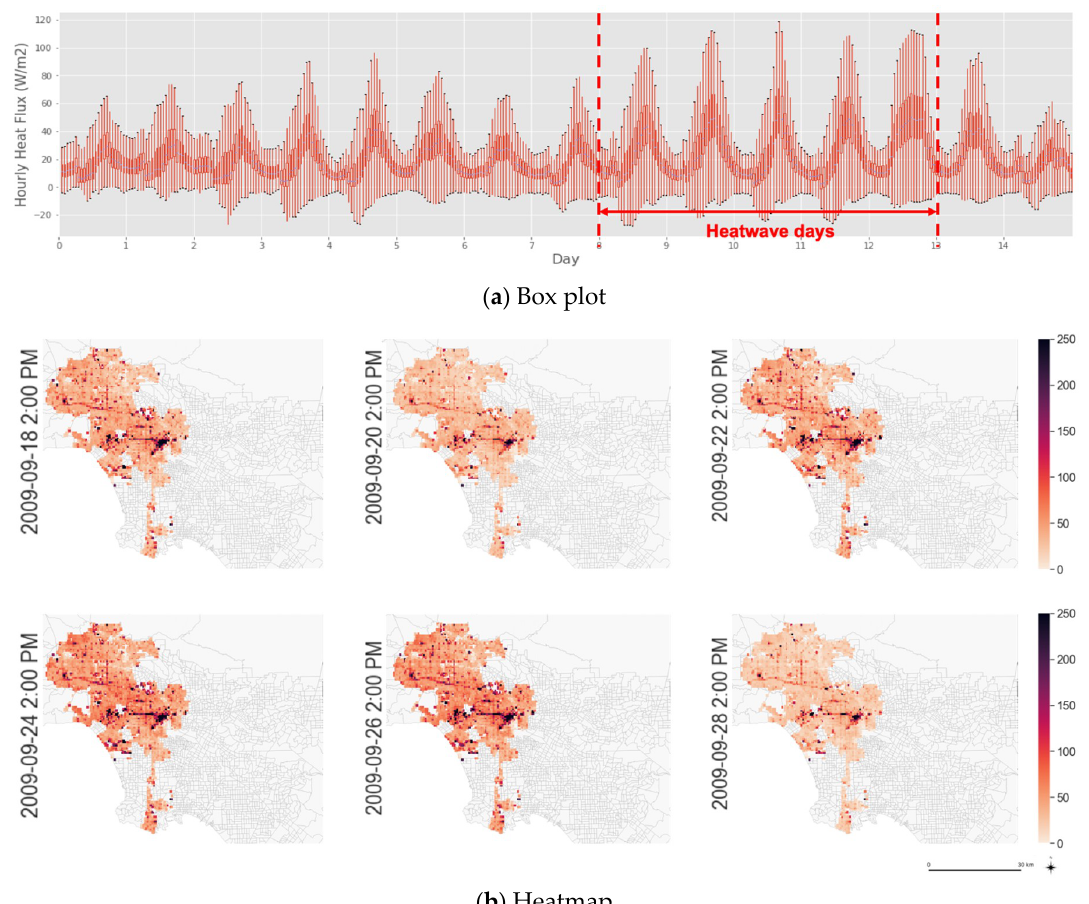
Figure 16. Spatial distributions of the heat flux from buildings. ( a ): Box plot ( b ): Heatmap.